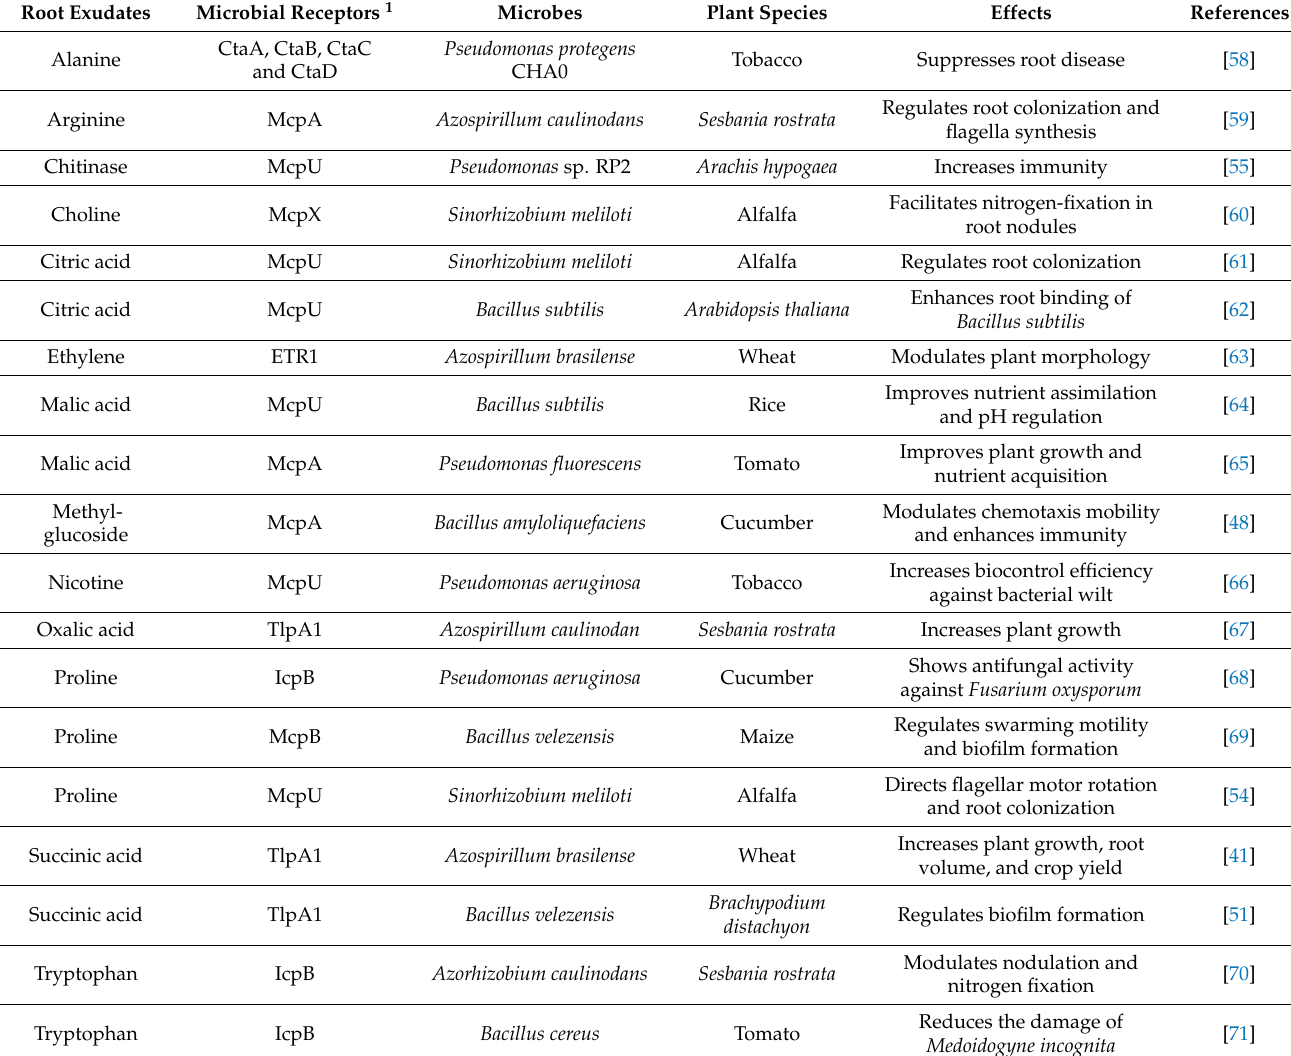
Table 1. Summary of some root exudates involved in plant–microbe crosstalk with subsequent impact on plant microbe